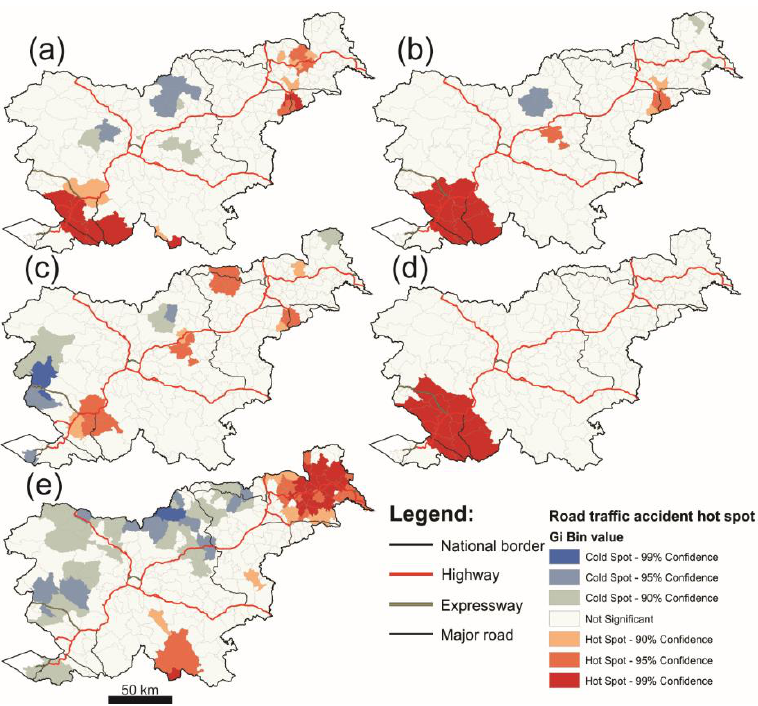
Figure 2. Road traffic crash hot and cold spots: ( a ) all crashes, ( b ) rain, ( c ) snow, ( d ) wind, ( e ) fog. Table 1. Predictor variables correlation matrix (Spearman’s correlation